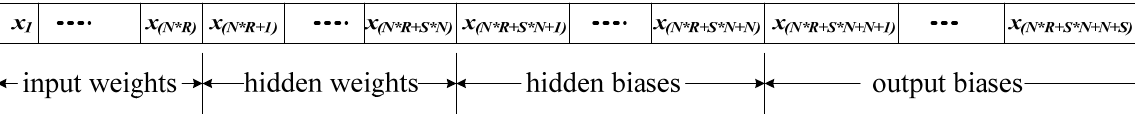
Figure 4. The vector of training